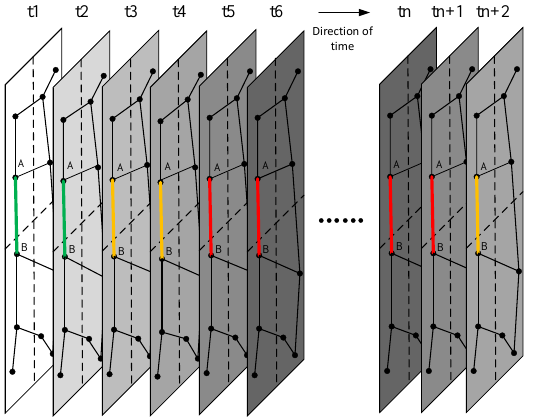
Figure 4. Situational the speed variation of road network in different